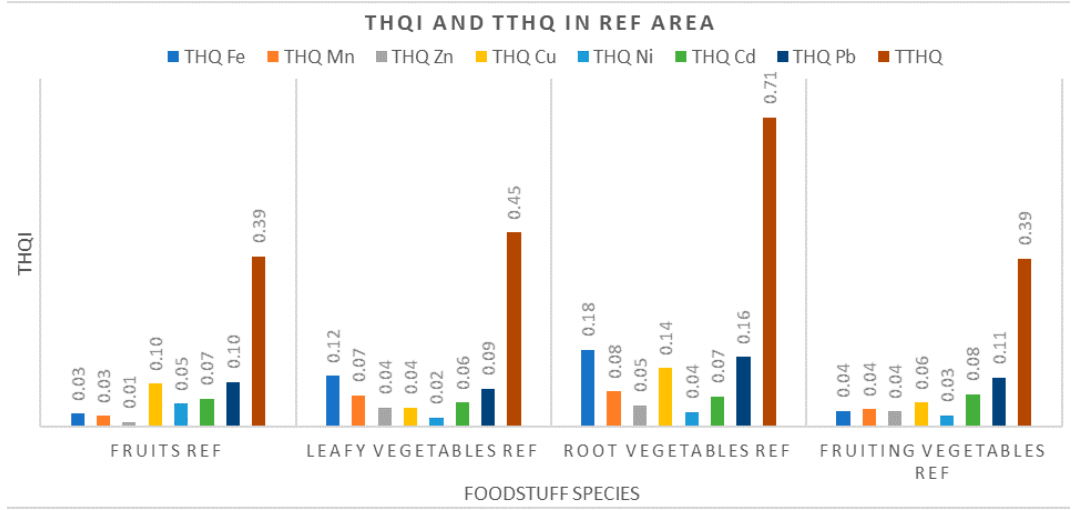
Figure 6. Measured values for THQi and TTHQ in the village of Borlova (Ref) area.